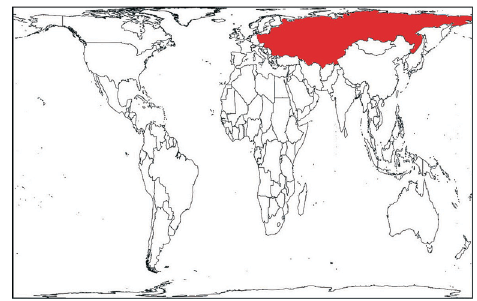
Fig. 14. Map of the world in Peters